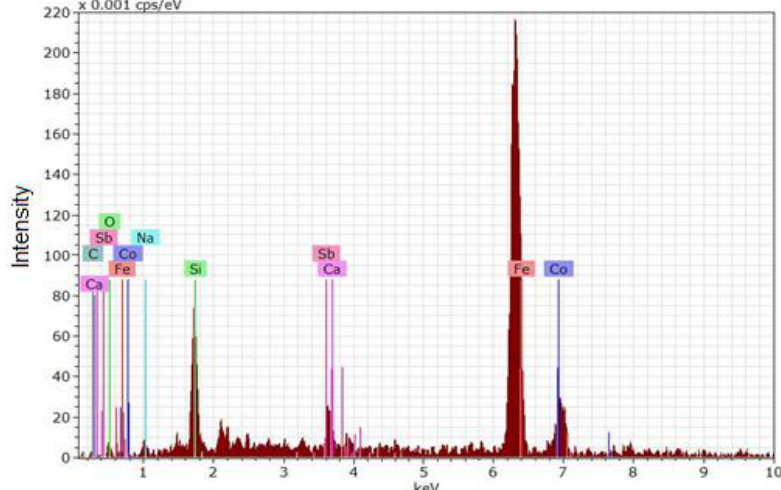
Fig. 6: The EDX energy of the alloy